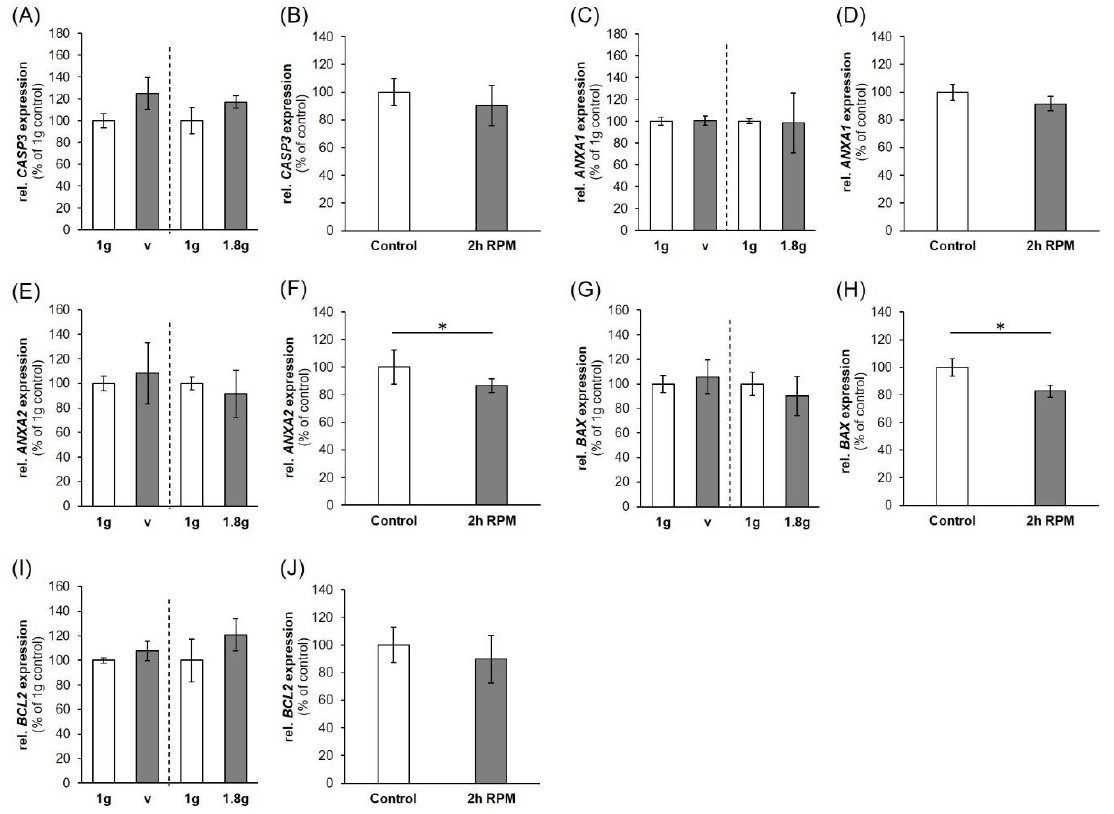
Figure 5. Influence of a VIB (V), hyper- g and iRPM-exposure on the gene expression of apoptosis signaling factors: ( A , B ) CASP3 , ( C , D ) ANXA1 , ( E , F ) ANXA2 , ( G , H ) BAX , ( I , J ) BCL2 . n = 5. The data are given as mean ± standard deviation. * p < 0.05 vs. 1 g -control.